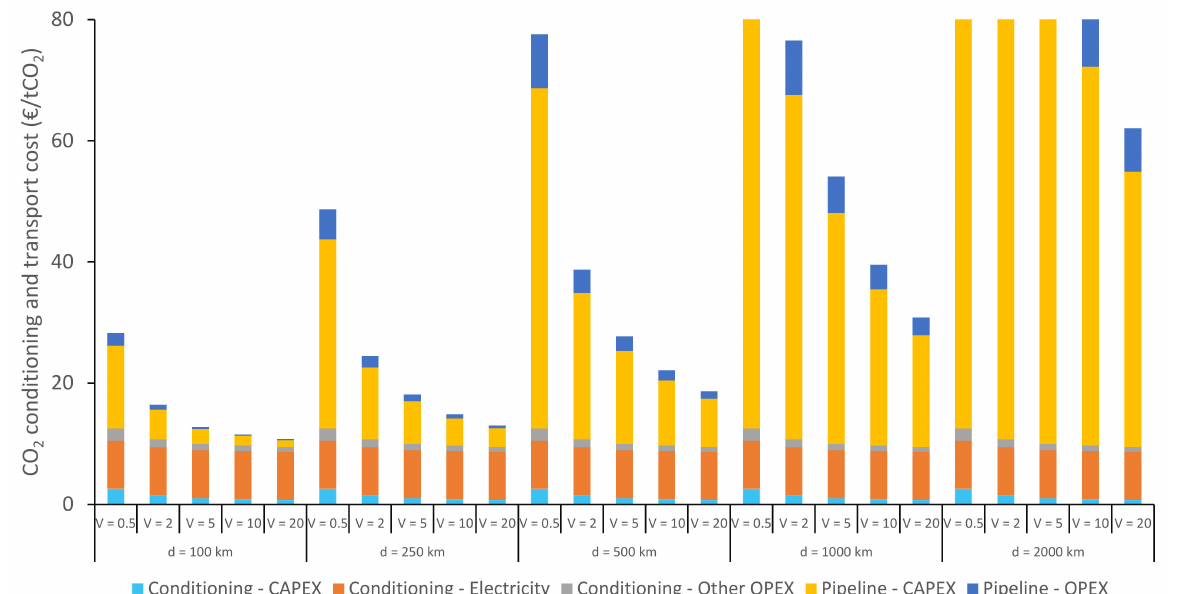
Figure A13. Cost breakdown of CO 2 conditioning and transport costs as a function of transport distance (d in km) and annual volume (V in MtCO 2 /year) when transporting pure CO 2 to an offshore site using an offshore pipeline (the upper y-axis is here limited to 80 € /tCO 2 , which means that some of the cost breakdown data are not displayed in